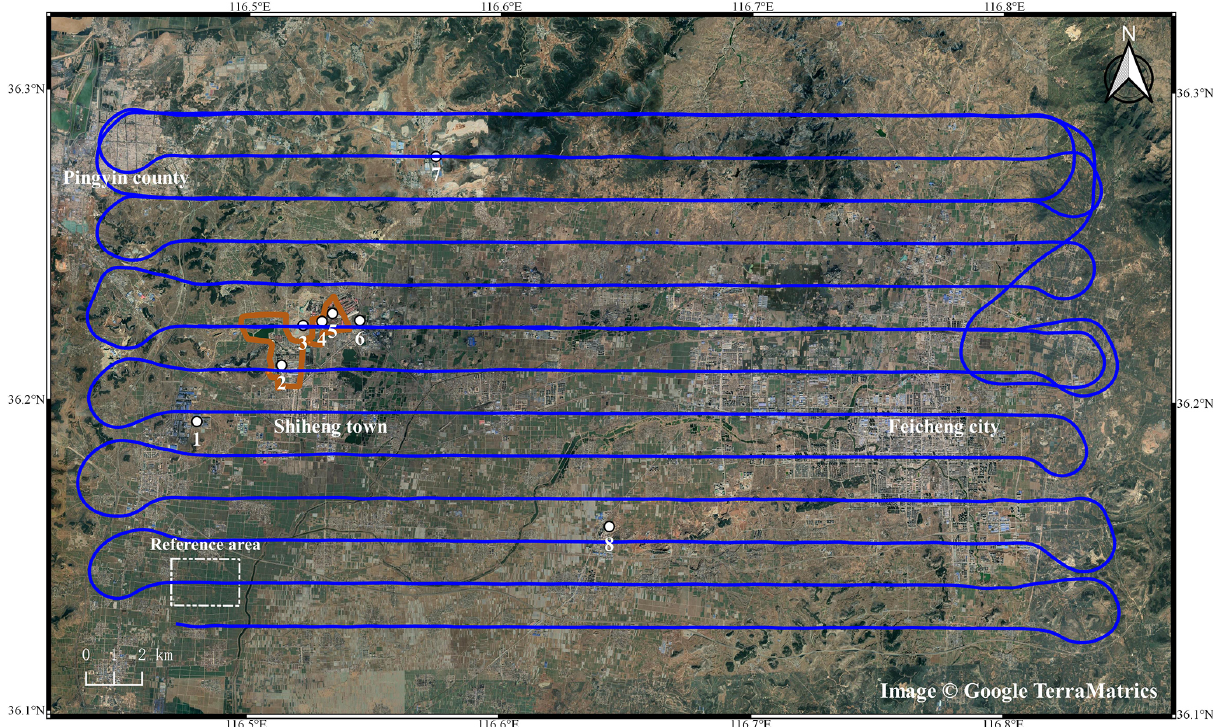
Figure 4. Overview of the Feicheng demonstration flight on 23 June 2018. Flight lines are shown in blue. Two orange circles represent the routes of the mobile DOAS system. White dots numbered from 1 to 8 represent the major emission sources. Number 1: several carbon factories; number 2: a power plant; numbers 3–6: individual emitters inside the steel factories, while numbers 4 and 5 are inside the circle of one mobile DOAS route; numbers 7–8: two cement factories. The dashed white box represents the reference